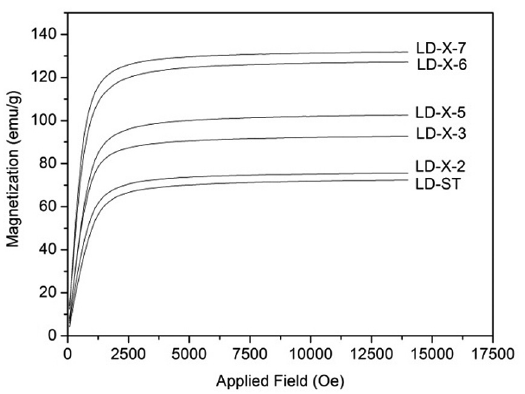
Figure 5. Magnetization curves of deformed specimens.